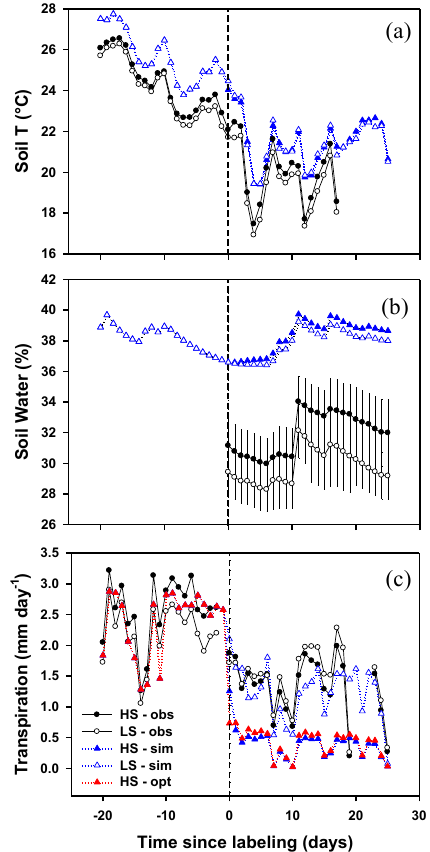
Figure 4. (a) Observed (obs) and CLM simulated (sim) daily soil temperature at 0–5cm depth (SD = 0.6–1.4 ◦ C), (b) volumetric soil water content at 15–95cm depth ( ± SD), and (c) the transpiration before and after initiation of light shade (LS) or heavy shade (HS) treatments (SD = 0.1–1.7mmday − 1 ). HS–opt represents the CLM simulation with optimized leaf conductance parameters. The verti- cal dashed lines indicate the starting day of the shade treatments.